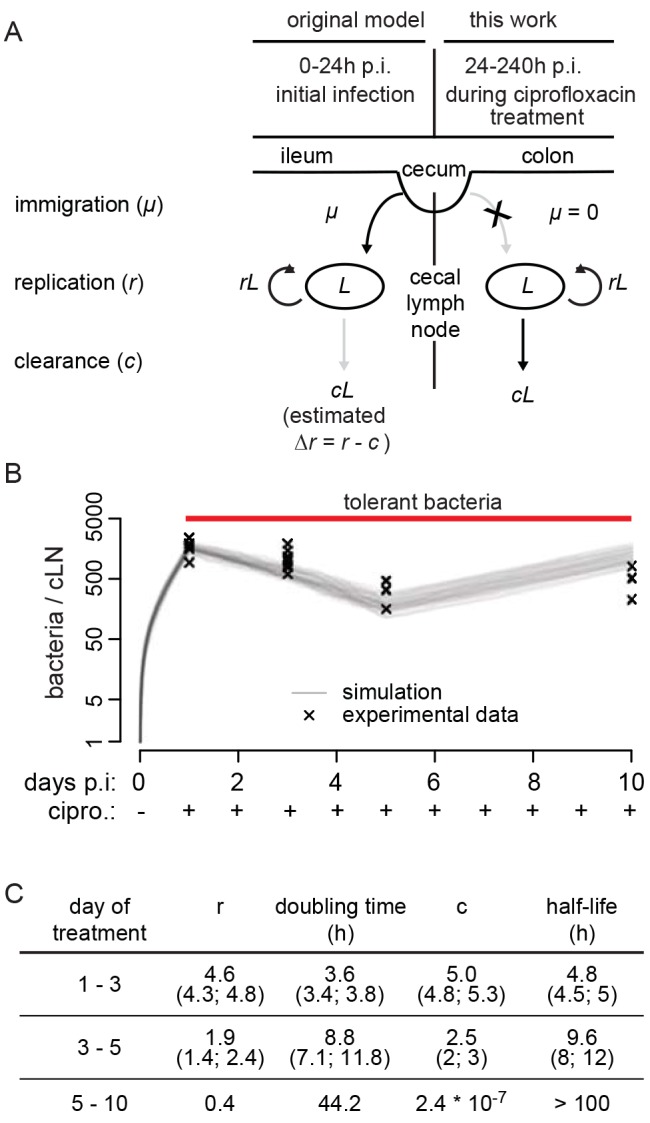

S. TmWITS infection and a modeling reveal slow growth of tolerant bacteria.(A) Schematic representation of the stochastic birth-death process modified by immigration and its parameterization (for details, see Materials and Methods). During the first 24 h p.i., we analyzed cLN colonization dynamics in absence of ciprofloxacin. Ciprofloxacin treatment was started by 24 h p.i. and continued until day 3, 5, or 10, as indicated. The model for analyzing the latter data is displayed on the right side. (B) Mice were infected with S. TmWITS and treated with ciprofloxacin (2×62 mg/kg/d by gavage) from day 1 p.i. until the indicated end of the experiment (day 1, n = 49; day 3, n = 28; day 5, n = 28; day 10, n = 28 data points). CFU determination and analysis of tag abundance using rtqPCR (experimental data, Table S2) was used to fit the mathematical model. Graphic display of experimental data (x) and 100 simulations (grey lines). (C) Parameters (with confidence intervals) derived from fitting the mathematical model to our experimental data. r, replication rate; doubling time, ln2/r×h; c, clearance rate; half-life, ln0.5/c×h.